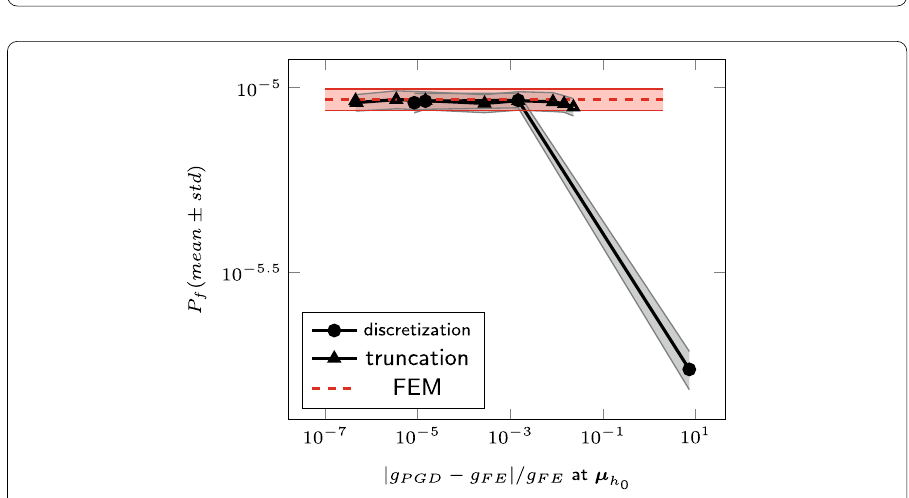
Fig. 13 Cross-section: influence of the refinement degree of the PGD model (given by Eq. 16) on the failure probability P f based on 50 runs of itPGDrel-PF with varying PGD solutions regarding mesh discretization and number of models ( μ h